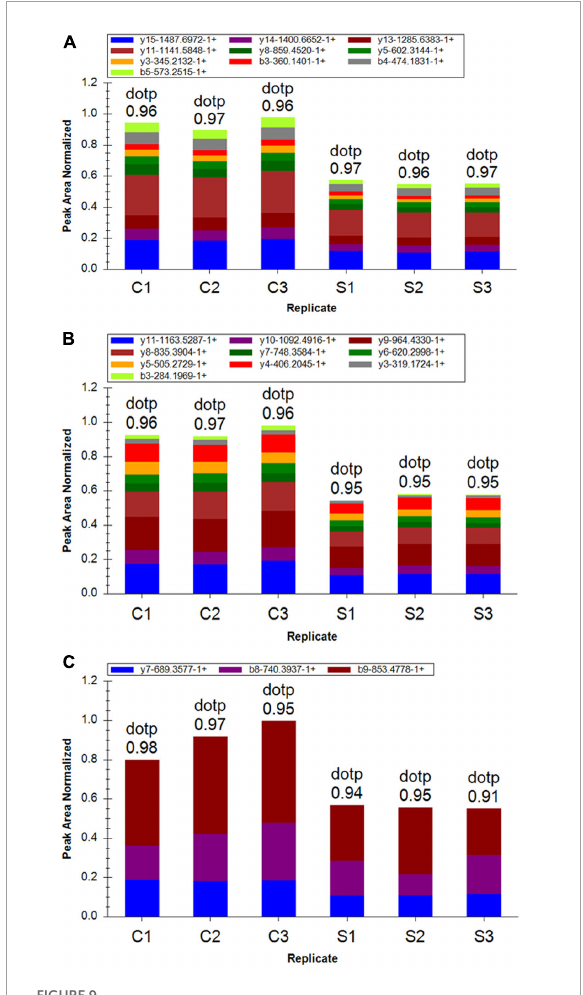
FIGURE9 Differentially expressed proteins (DEPs) quantification by mass spectrometry-based targeted proteomics-parallel reaction monitoring (PRM). (A) Fragment ion peak area distribution of TEENVSDGSPNAGTVEQTPK peptide for Cdkn1b (P27). (B) Fragment ion peak area distribution of VLAQESQDVSGSR peptide for Cdkn1b (P27). (C) Verification of peptide VALGDGVQLPPGDYSTTPGGTLFSTTPGGTR targeting protein